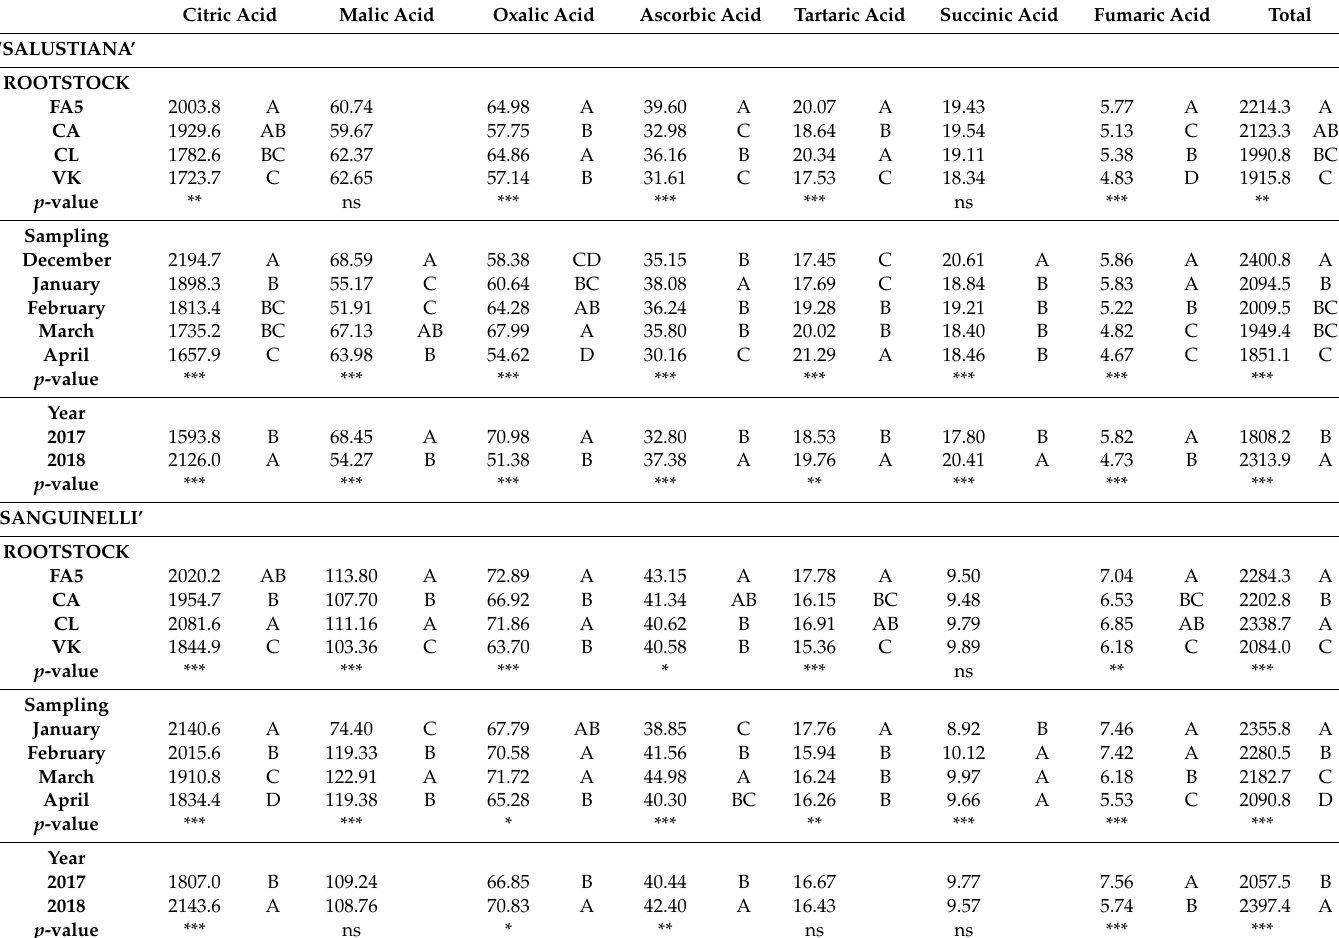
Table 1. E ff ect of rootstock, sampling date, and year on organic acid concentration in ‘Salustiana’ and ‘Sanguinelli’ cultivars. Organic acids are expressed in mg / 100 g